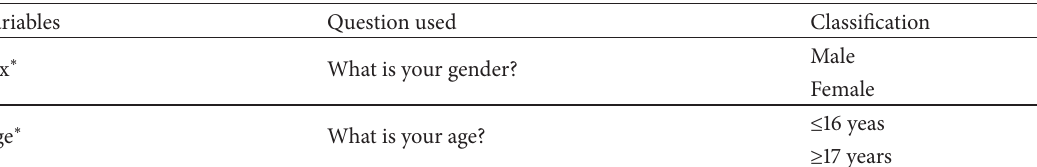
Table 1: Characterization of variables used in this